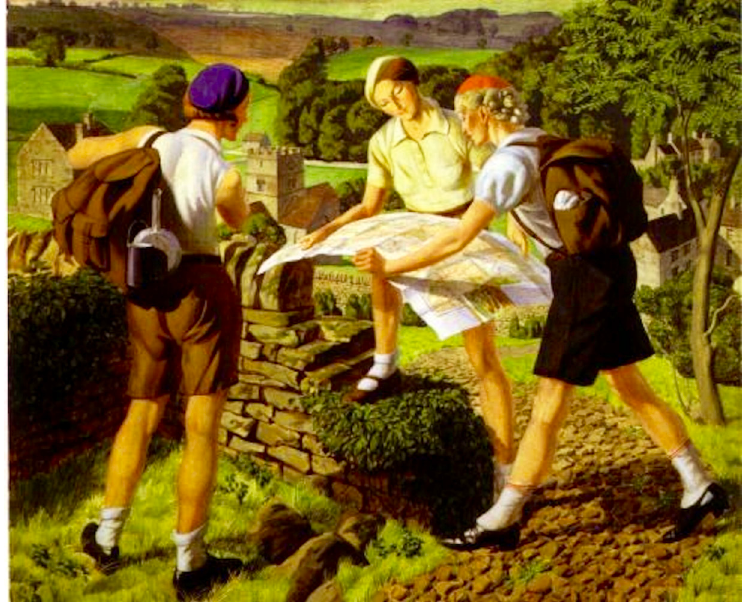
Figure 4.1 J. W. Tucker, Hiking (1936). Photo credit: Laing Art